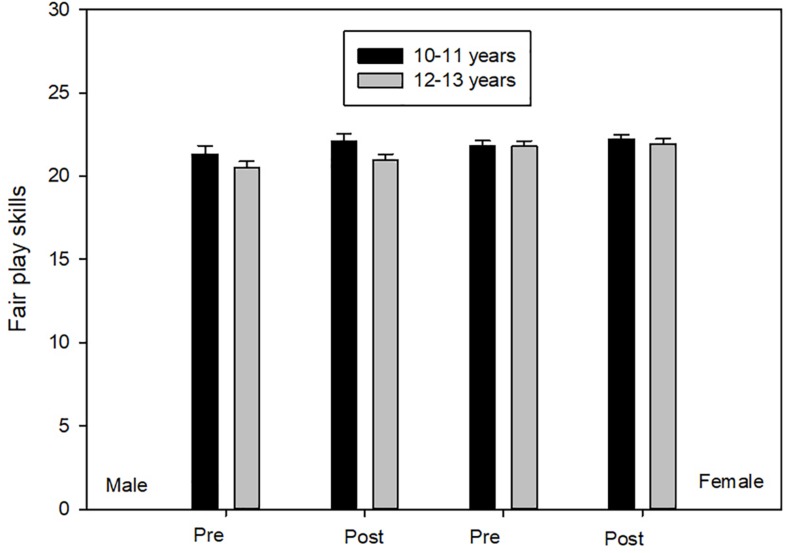
Fair play skills.